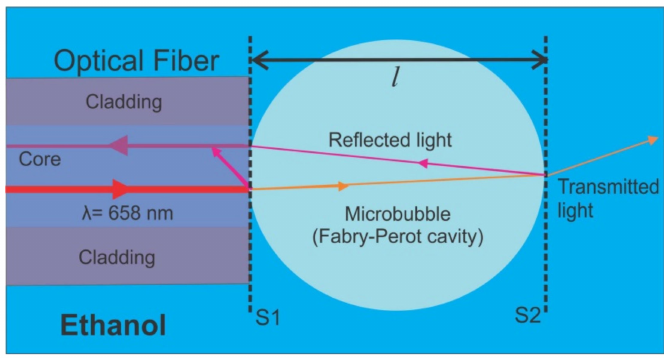
Figure 1. Diagramoftheinteractionoflightintoamicrobubble,